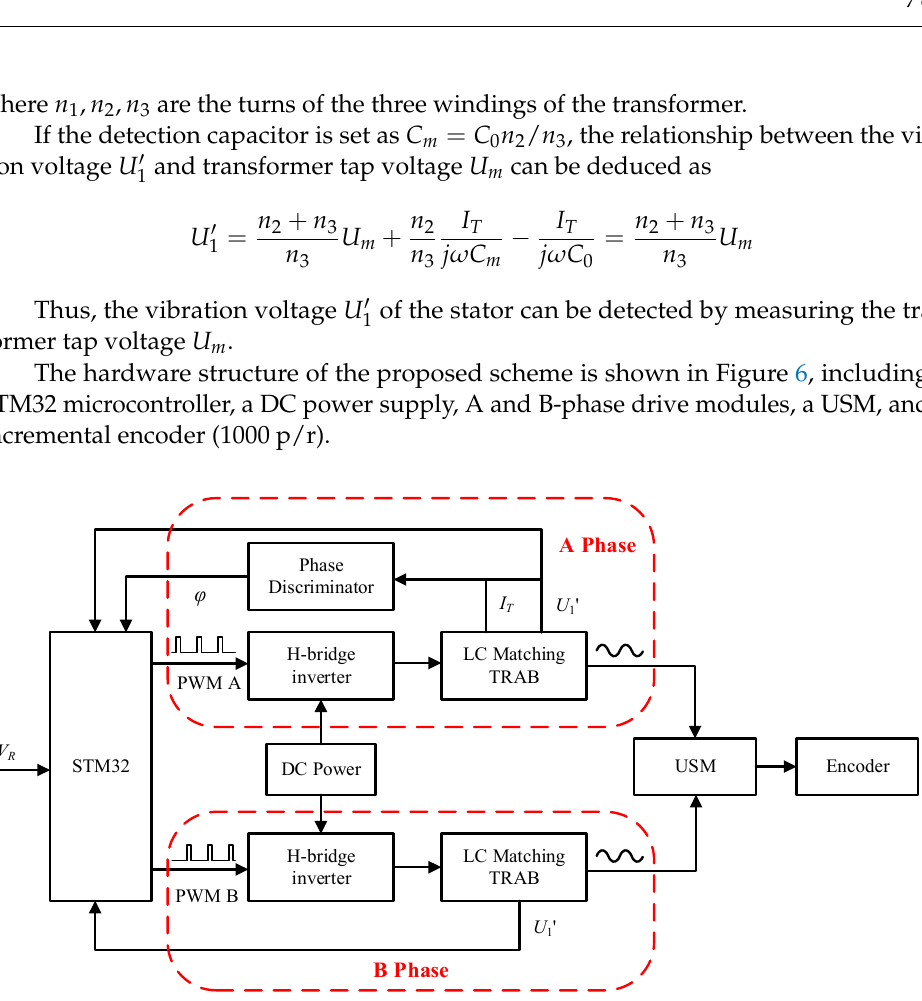
Figure 6. Hardware architecture of the proposed scheme.